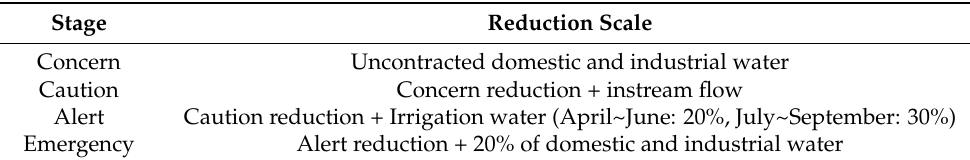
Table 3. Description of four stages (concern, caution, alert, and emergency) and reductions scales for multipurpose reservoir.